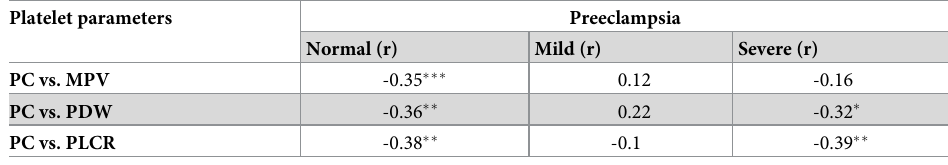
Table 3. Correlation between platelet parameters in NT, mPE and sPE pregnant women visiting ACSH and MGH, Mekelle, Ethiopia, January–March 2017 (n =